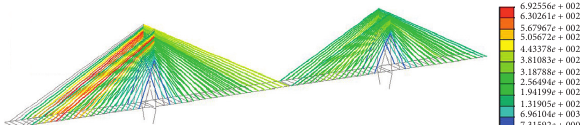
Figure 29: Cable force distribution after repair (unit: